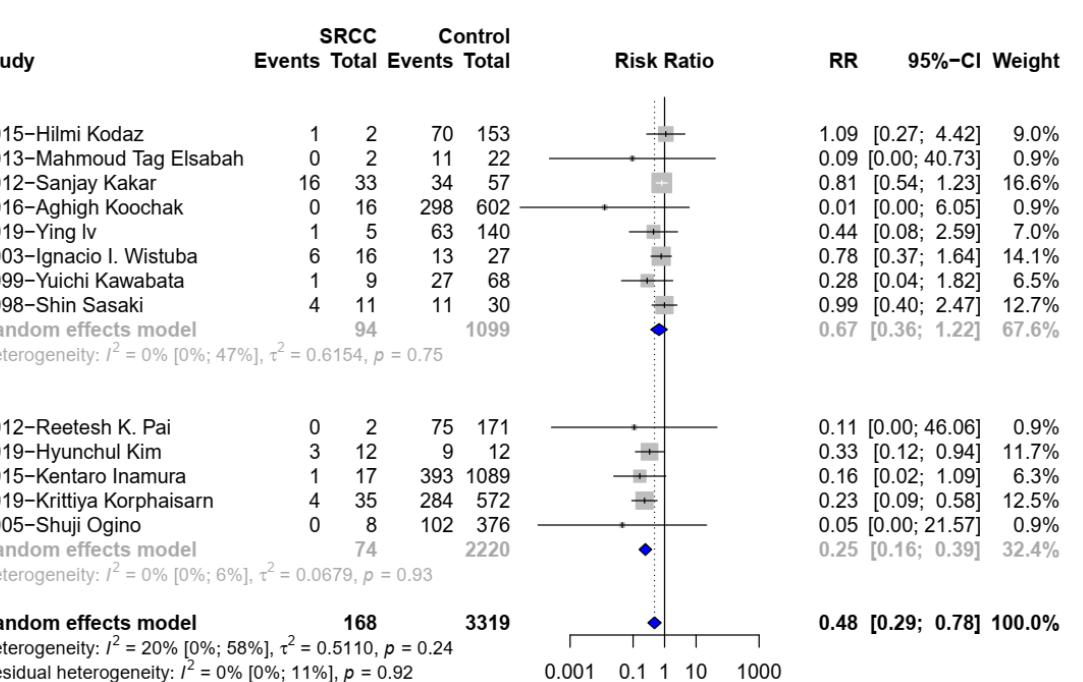
Figure 2. ( 1 ). Forest plot for KRAS between SRCC and non-SRCC (SRC component < 50% was not excluded). ( 2 ). Forest plot for KRAS between SRCC and C-CRC.